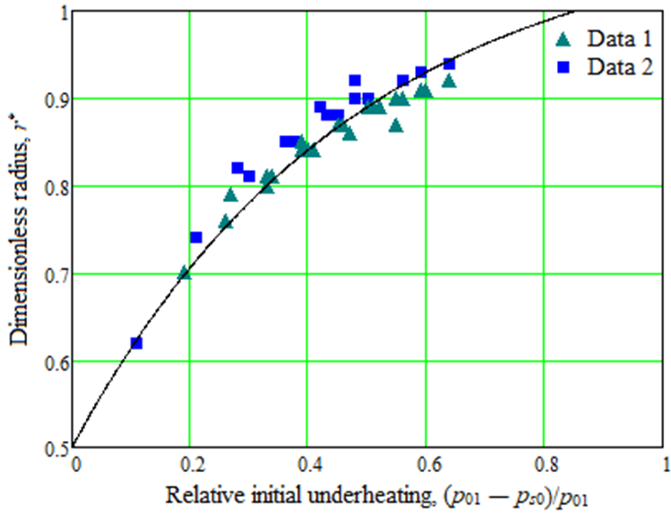
Figure 7. Dependence of the relative initial underheating on the modified Euler number.